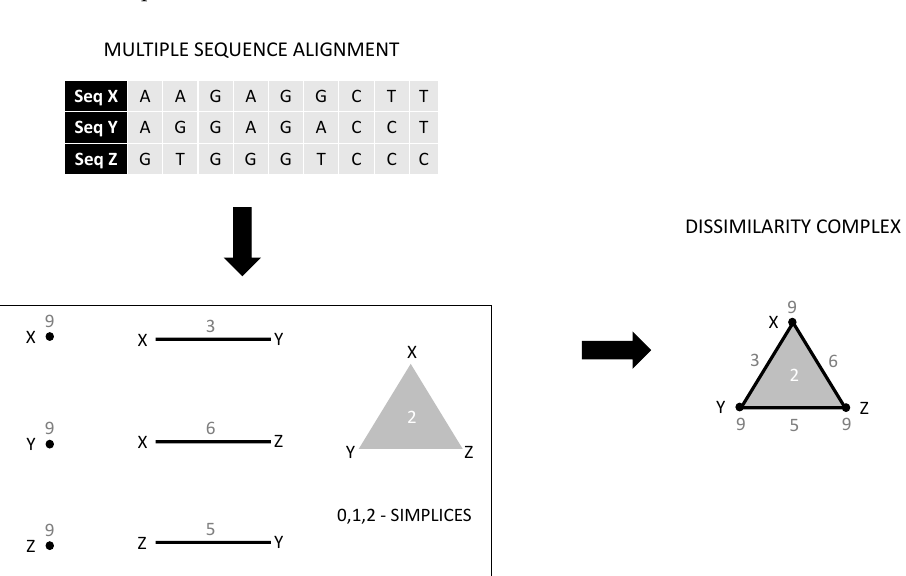
Figure 5. Left: an interaction structure with two interaction arcs, x and y . Right: the corresponding interaction complex.